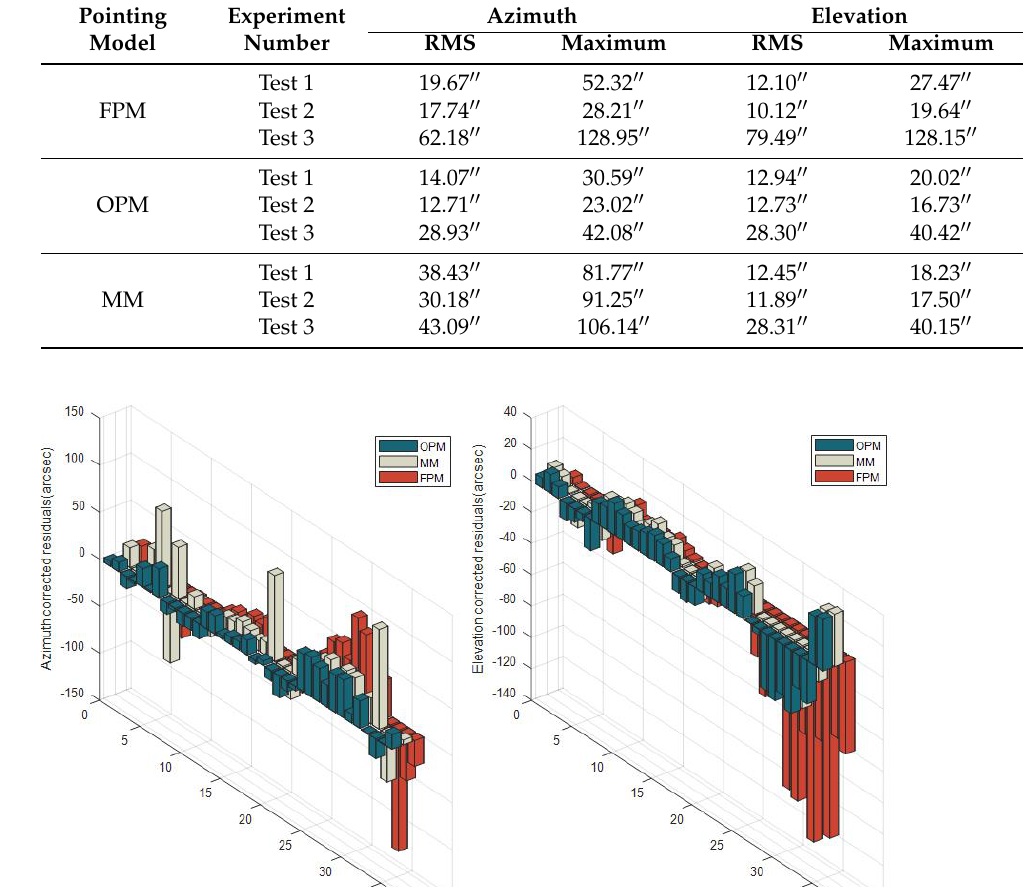
Table 1. Pointing precision of the EOT after correction.